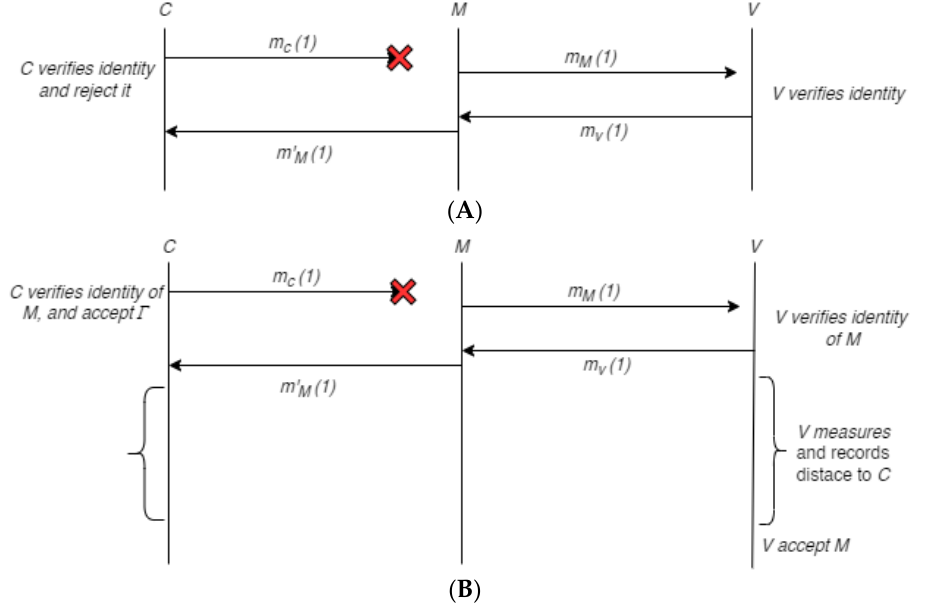
Figure 9. ( A ) Vehicle R ’s Markov chain random walk model while ( B ) The verifier selects M check- points and R has N potential states.